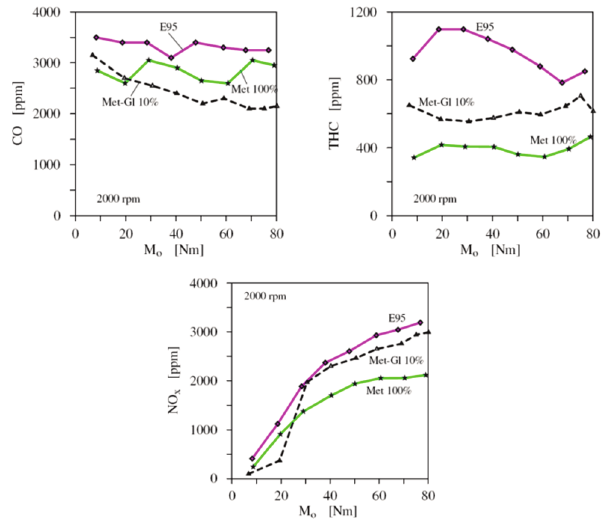
Fig. 2. Content of toxic components of flue gas resulting from the combus- tion of various fuel mixtures [7]